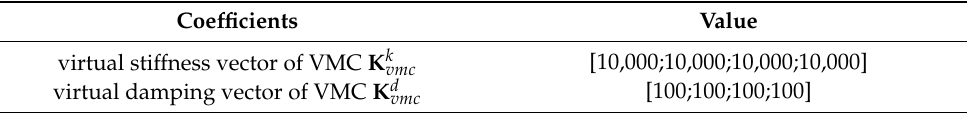
Table 4. Coefficients of VMC.